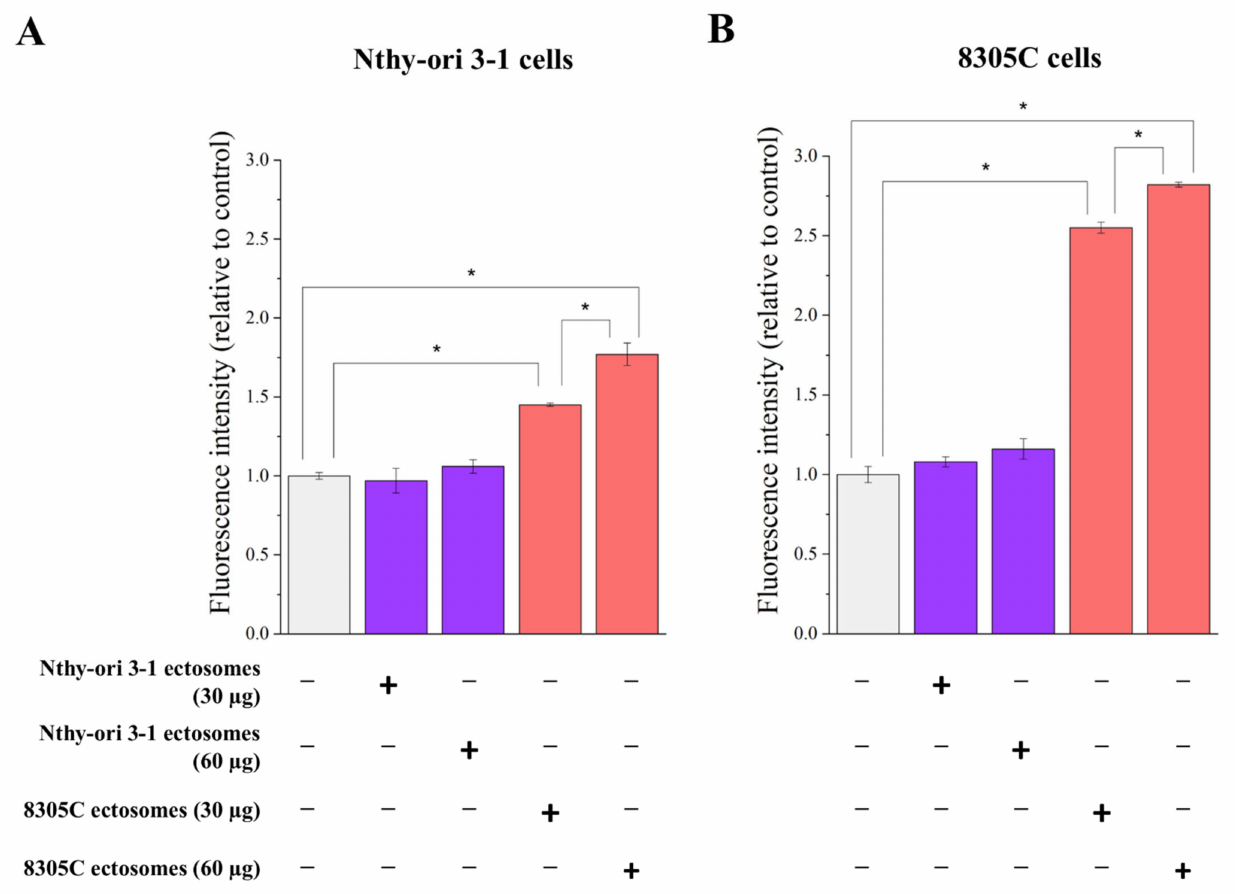
Figure 9. The effect of incubation of normal thyroid follicular epithelial Nthy-ori 3-1 cells ( A ) and thy- roid anaplastic carcinoma 8305C cells ( B ) with ectosomes released by these cells. Alamar Blue cell via- bility assay was carried out after 18 h of incubation with ectosomes. All experiments were